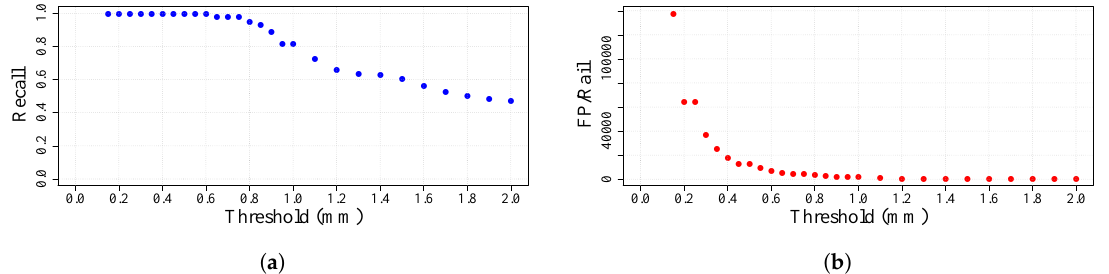
Figure 11. Segmentation threshold exploration. ( a ) is the evolution of the Recall depending on the value of the segmentation threshold. ( b ) is the evoution of the number of False Positives per Rail depending on the value of the segmentation threshold.